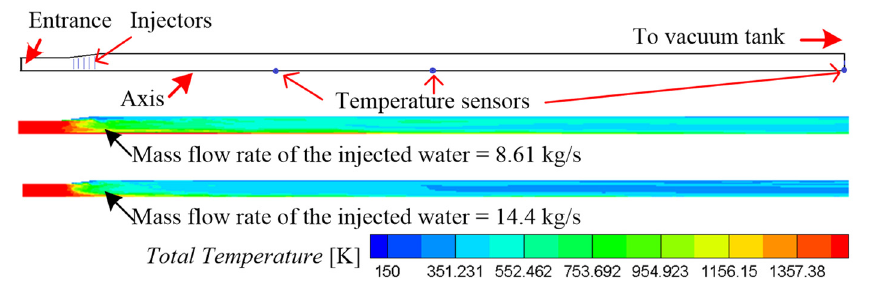
Figure 9. The configuration the experimental model and the corresponding numerical results.